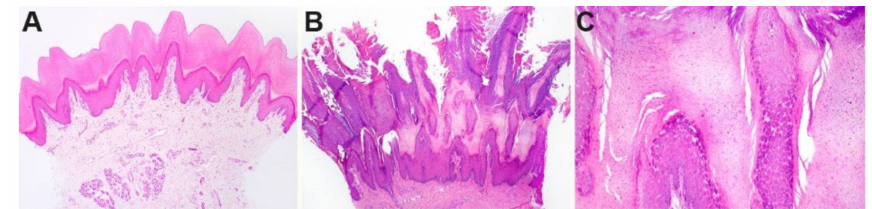
Figure 2. Histopathological phenotype of footpad skin. ( A ) Footpad skin of a normal six-month-old control dog. ( B ) In a biopsy taken from the a ff ected dog at six months of age, a dense proliferation of the stratum corneum (outermost anucleated layer of the skin) markedly expands the epidermis. The stratum corneum is arranged in papillated villous projections of dense keratin. ( C ) Higher magnification of the